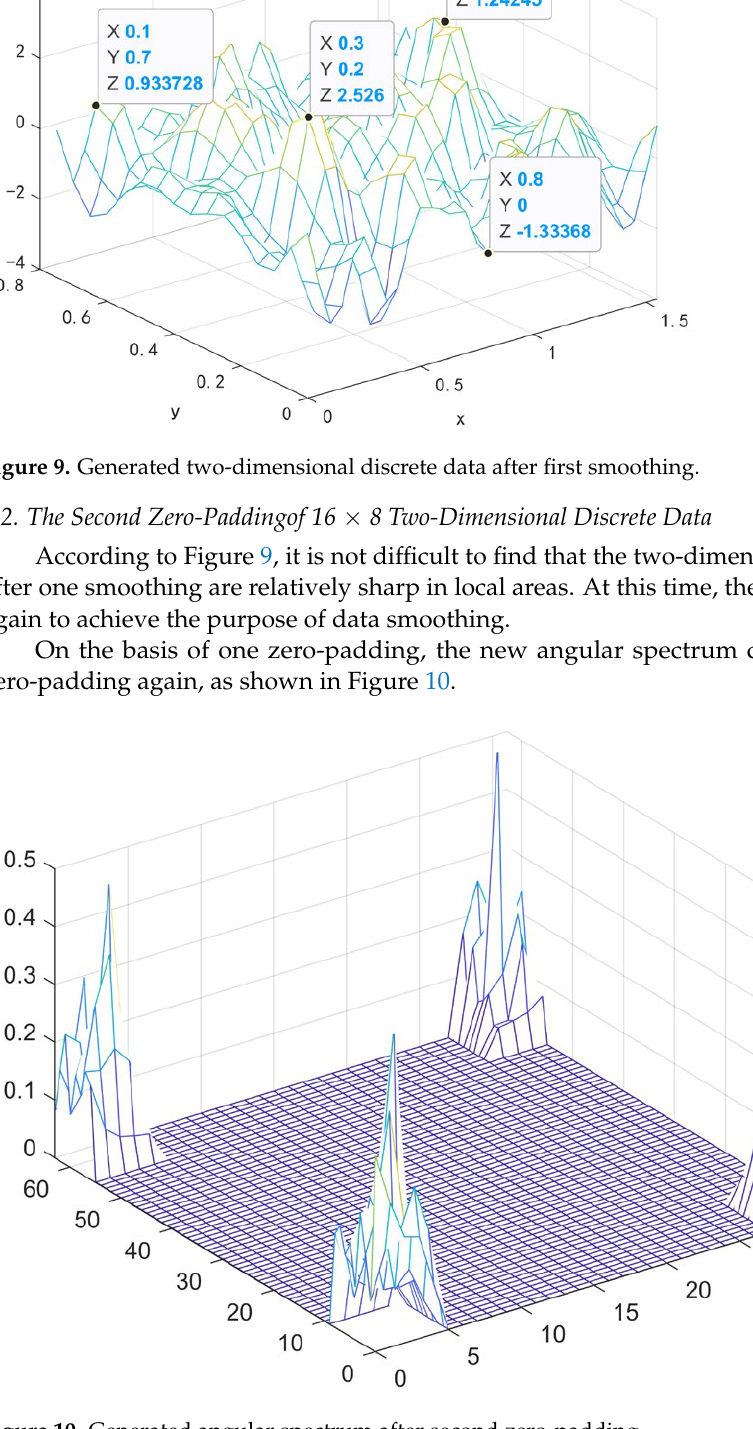
Figure 10. Generated angular spectrum after second zero-padding. The angular spectrum after two zero-paddings is transformed by IDFT to obtain two-dimensional discrete data after twice smoothing, as shown in Figure